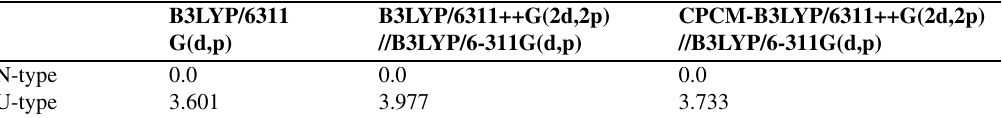
Table 4. The calculated relative energies of products Product Relative energy (kcal mol –1